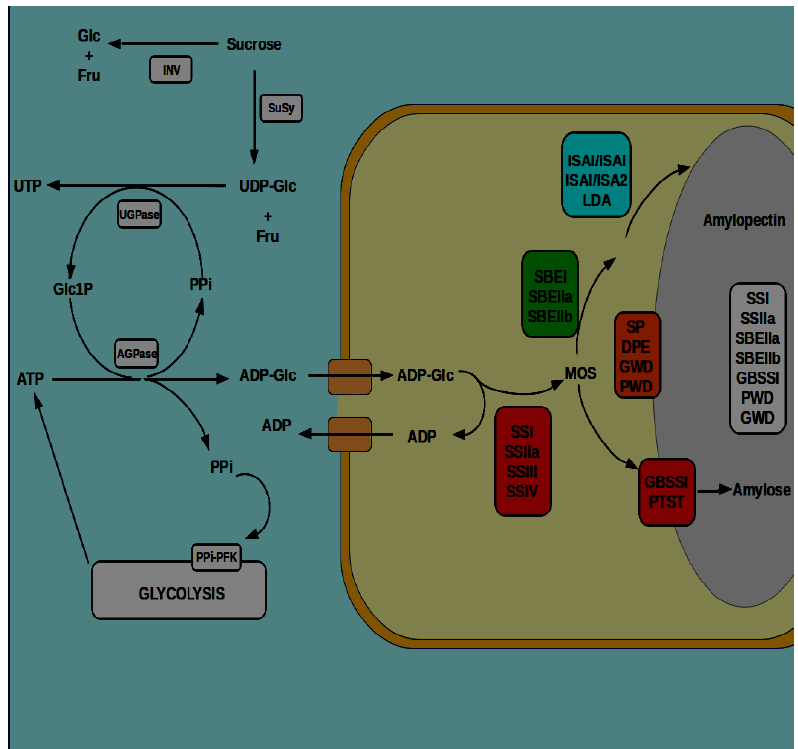
Figure 3. Outlines the starch biosynthetic pathway operating in the heterotrophic tissue of the developing endosperms of the Poaceae utilizing sucrose derived from photosynthetic tissues. Examination of this pathway reveals the major distinction of the pathway of storage starch synthesis in grasses and cereals is in the provision and delivery of the carbon precursor ADP-Glc. Cereals and grasses possess a cytosolic form of ADP-Glc pyrophosphorylase (AGPase) in addition to the plastidial isoform found in other tissues and plant species. ADP-Glc is imported to the amyloplast via counterexchange with ADP by the transport protein BT1. Inorganic pyrophosphate (PPi) consumption by UDP-Glc pyrophosphorylase (UGPase) and PPi-dependent phosphofructokinase (PFK), and generation of Glc1P (from UGPase) and ATP (glycolysis) favours formation ADP-Glc via the cytosolic AGPase reaction. Inside the amyloplast the major enzymatic reactions involved in starch synthesis are enclosed in boxes; red, starch synthases (SS); green, starch branching enzymes (SBE); and blue, debranching enzymes (DBE), including limit dextrinase (LDA). Enzyme activities whose precise role in the overall pathway is not clear are enclosed in an orange box; starch phosphorylase (SP), disproportionating enzyme (DPE), glucan water-dikinase (GWD), and phospho-glucan water-dikinase (PWD). Starch biosynthetic enzymes in the white box are isoforms found tightly associated with the starch granule (granule-bound proteins). All other enzymes in the cytosol are represented as white boxes. AGPase, ADP-Glc pyrophosphorylase; INV, invertase; SuSy, sucrose synthase; UGPase, UDP-Glc pyrophosphorylase.